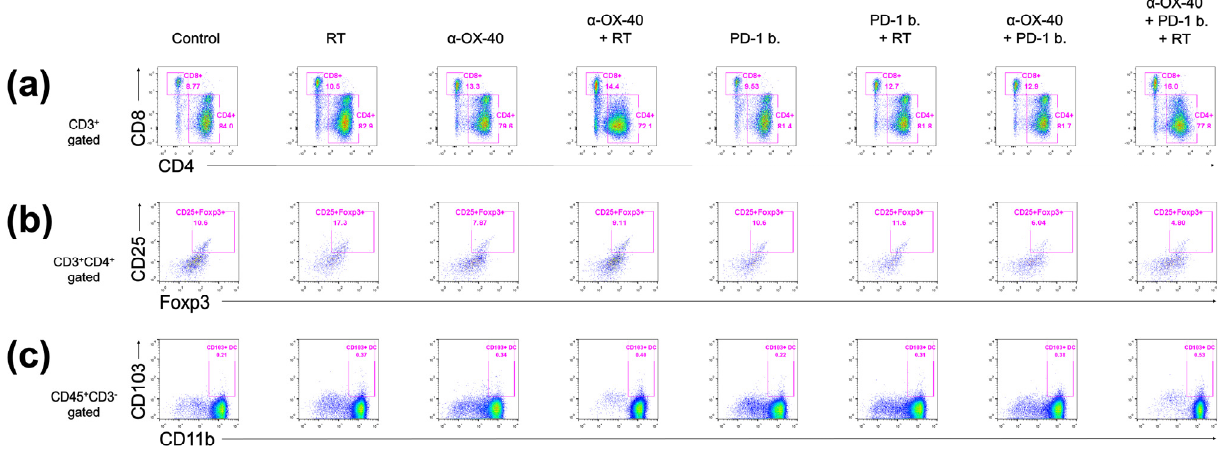
Figure 2. Immune cell profiles in the spleen. Representative flow cytometry plots for ( a ) CD4+ or CD8+ T cells, ( b ) CD4 + FOXP3+ Tregs, and ( c ) CD45 + CD103+ dendritic cells. ( d – h ) Cell population percentages calculated from flow cytometry analyses. ELISpot quantification of ( i ) IFN- γ , ( j ) IFN- β , and ( k ) TNF- α plasma levels. ( l ) Cytometric bead array results for IL-6 plasma levels. * p < 0.05, ** p < 0.01, *** p < 0.001, **** p < 0.0001. Abbreviations: CON, control; RT, radiotherapy; Treg, regulatory T cell; DC, dendritic cell; ns, not significant. Plasma IFN- γ and IFN- β levels were significantly increased by RT, whereas α -OX40 and PD-1B had minimal effects (Figure 2i,j). The increase in IFN- β levels was not eminent only when RT was added to PD-1B monotherapy. TNF- α levels were significantly ele- vated in the triple combination group (Figure 2k). The levels of IL-6, a cytokine known to inhibit TGF- β -induced Treg differentiation, were also higher in the two groups treated by α -OX40 and PD-1B with or without RT, although it did not reach statistical significance (Figure 2l) [34,35]. Although α -OX40 and RT had inconsistent effects on the CD4+ T cell population in spleen tissues (Supplementary Figure S1a), the addition of α -OX40 to either RT or PD-1B significantly increased the number of effector memory CD4+ T cells observed in the spleen (Supplementary Figure S1b). 3.3. Anti-Tumor Immunomodulatory Effects of α -OX40 Co-Stimulation and RT in the TME Flow cytometry and immunohistochemistry demonstrated similarly favorable im- munomodulatory effects of α -OX40 and RT in the TME (Figure 3). The treatment of α - OX40 or PD-1B significantly increased the number of tumor-infiltrating leukocytes but not RT (Figure 3a). The addition of α -OX40 or RT significantly increased the number of tumor-